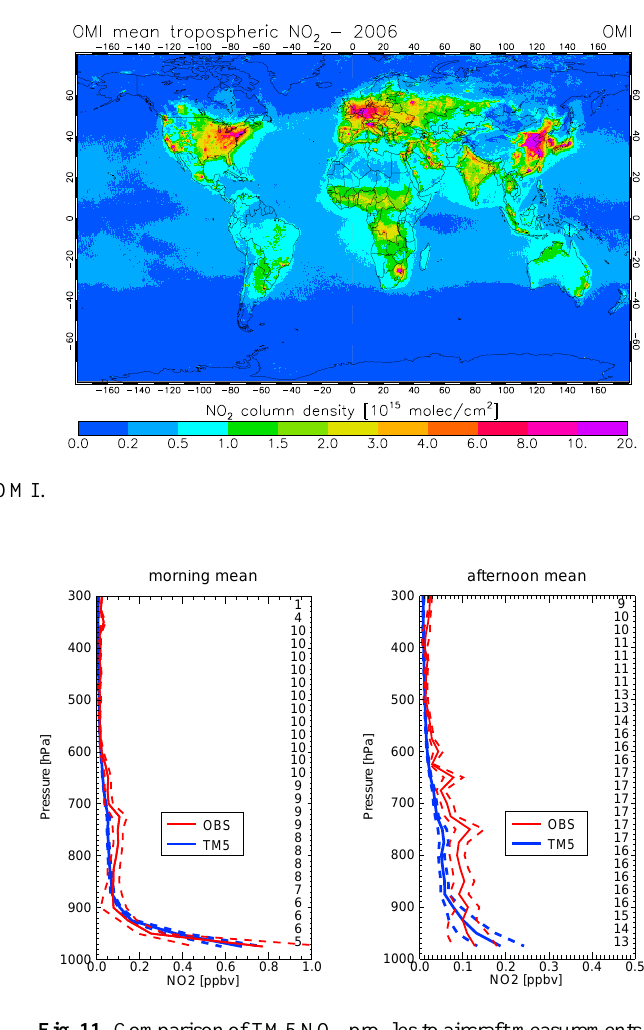
Fig. 11. Comparison of TM5 NO 2 profiles to aircraft measurements from the INTEX-B campaign over Mexico and the Gulf of Mexico during March 2006. Data is split into local times between 08:00– 11:00h (morning mean, left panel) and 11:00–16:00h (afternoon mean, right panel). On the right side of the panels the number of available measurements in 25-hPa pressure bins is given. Dashed lines indicate the standard deviation of all individual observations and model results with respect to their